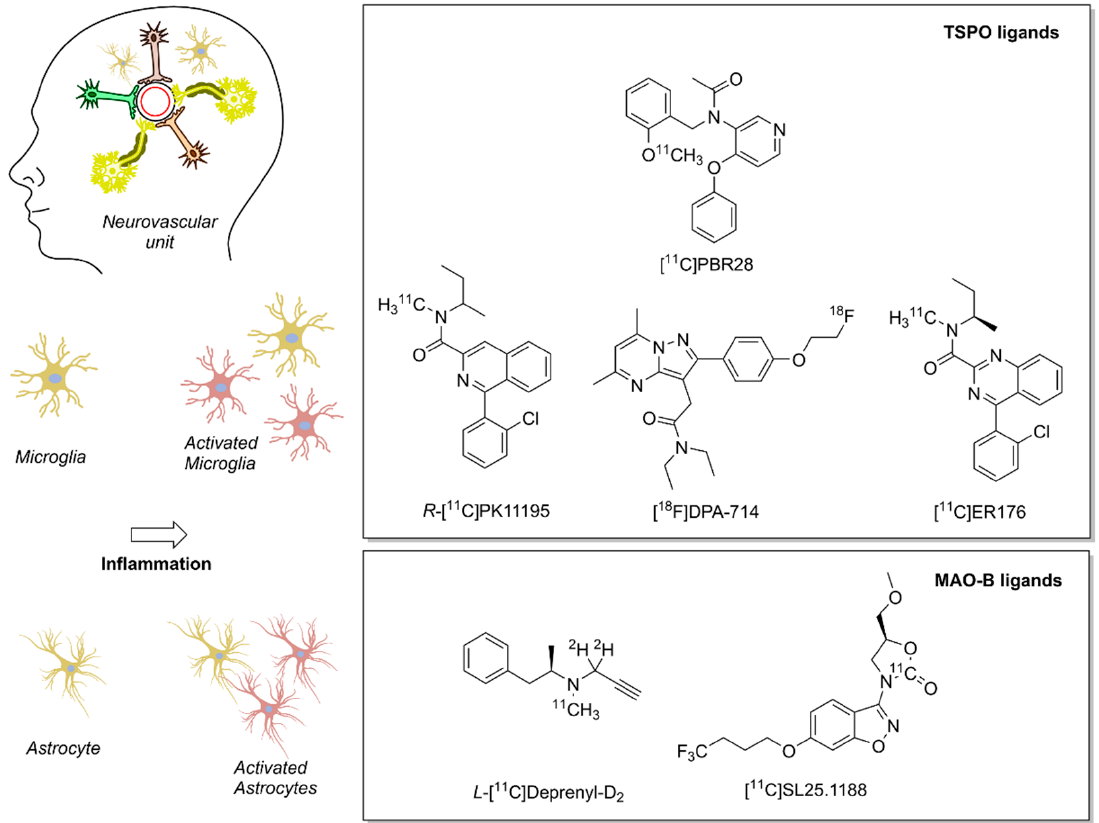
Figure 3. Positron emission tomography (PET) radioligands for translational molecular imaging of two biomarkers of neuroinflammation. The 18 kDa translocator protein (TSPO) and the enzyme monoamine oxidase B (MAO–B) are overexpressed in response to inflammation predominately in microglia and astrocytes, respectively.